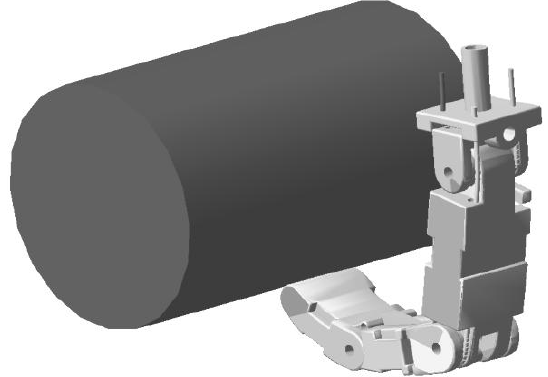
Figure 13. The finger makes contact with the environment in